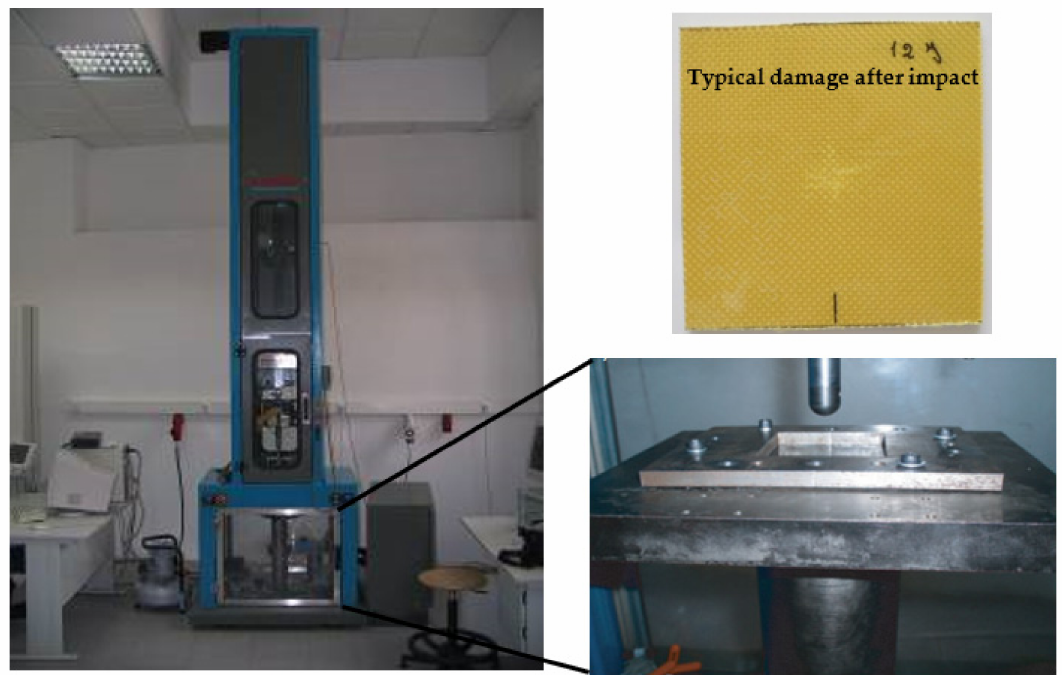
Figure 2. Details of the drop weight testing machine and a specimen with typical damage obtained after an impact with 12 J and immediately before immersion in hostile